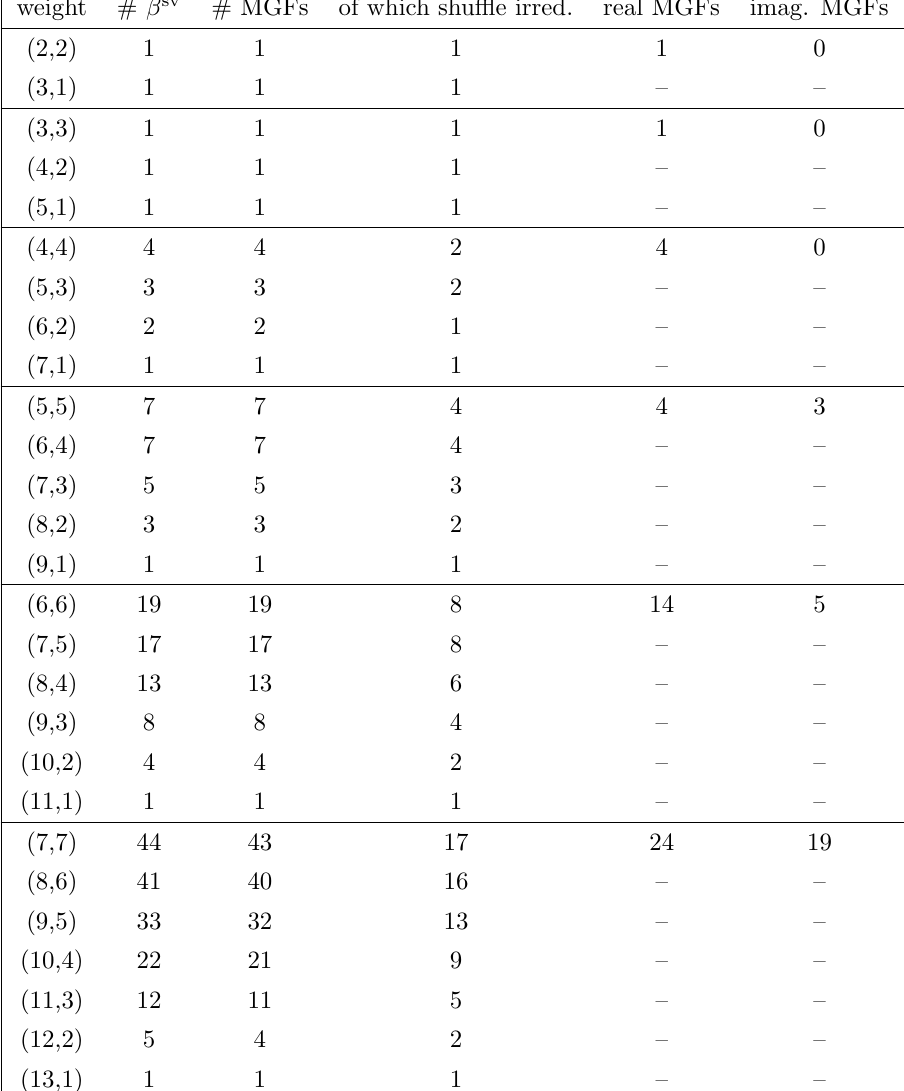
{ { , leading to a mismatch ~(cid:17)